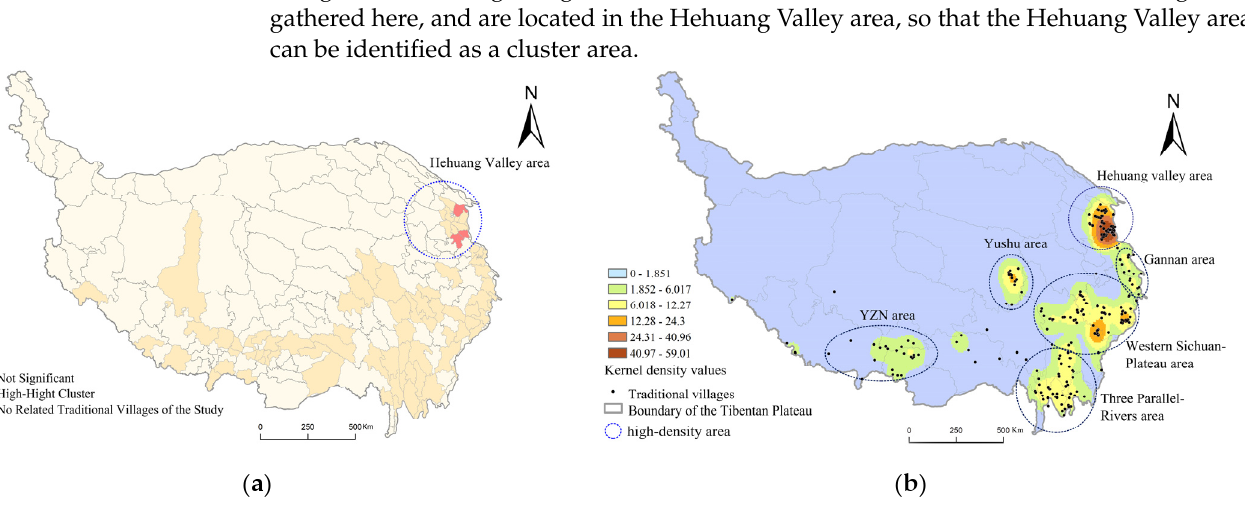
Figure 4. High-density and cluster areas of traditional villages on the Tibetan Plateau: ( a ) cluster map of villages based on the tool of Anselin local Moran’s I; ( b ) density map of villages based on the tool of kernel density.